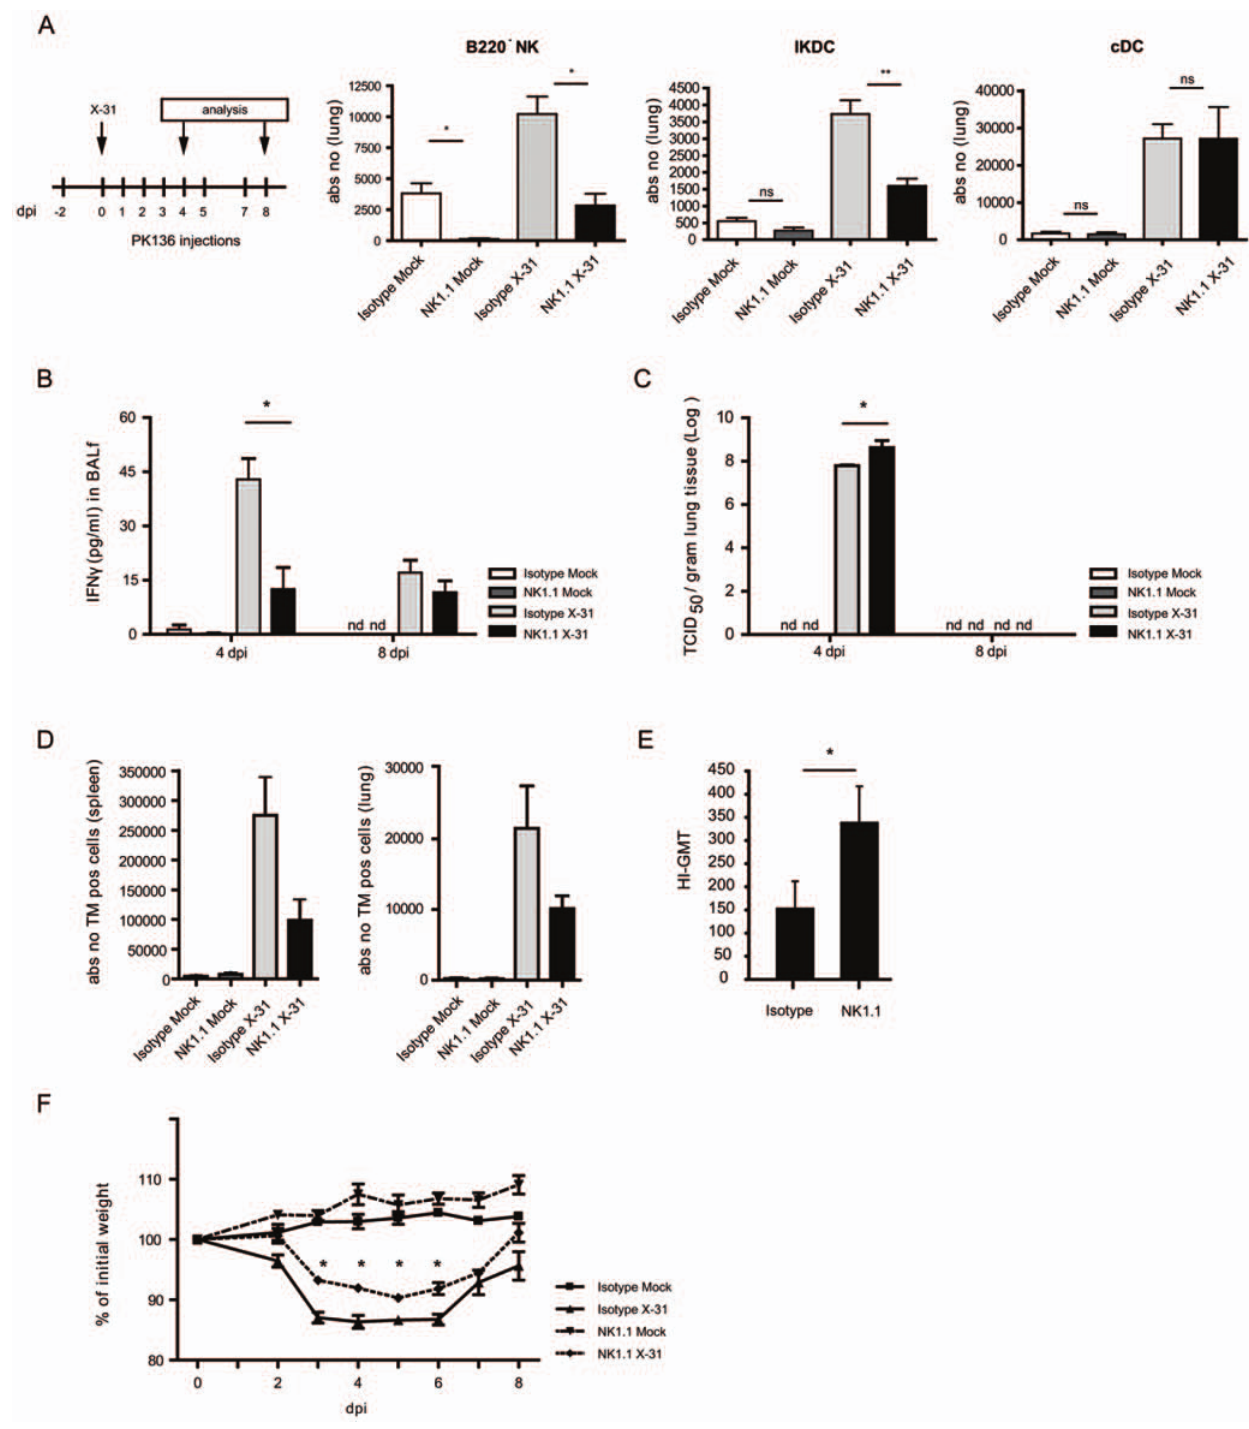
Figure 5. Depletion of NK1.1 + cells during in vivo influenza virus infection affects infection parameters. (A) 2 days after injection of PK136 (NK1.1 depleting antibody), mice were infected with X31 virus. Two days later, depletion of NK subsets and cDCs was checked in lung tissue by using the gating strategy in Figure 1. (B) IFN- c was measured in BALf of infected mice versus mock-infected mice with or without NK1.1 + cell depletion. Bars represent mean values of IFN- c + / 2 SEM. At least 5 mice per group were used, * p , 0,05. (C) Viral titers were measured in lung tissue of at least 5 mice per group and expressed as mean TCID 50 + / 2 SEM. * p , 0,05. (D) Absolute numbers of TM specific CD8 + T cells were measured in spleen and lung tissue at 8 dpi and represented as mean values + / 2 SEM, of at least 5 mice/group. (E) Hemagluttinin specific antibodies in serum were measured at 8 dpi and depicted as geometric mean titer + / 2 SE. * p , 0,05. (F) Weight loss of mice during infection depicted as % of initial weight. Values indicate mean of at least 5 mice per group + / 2 SEM.*p , 0,05. The demonstrated data are representative of 4 independently performed experiments.